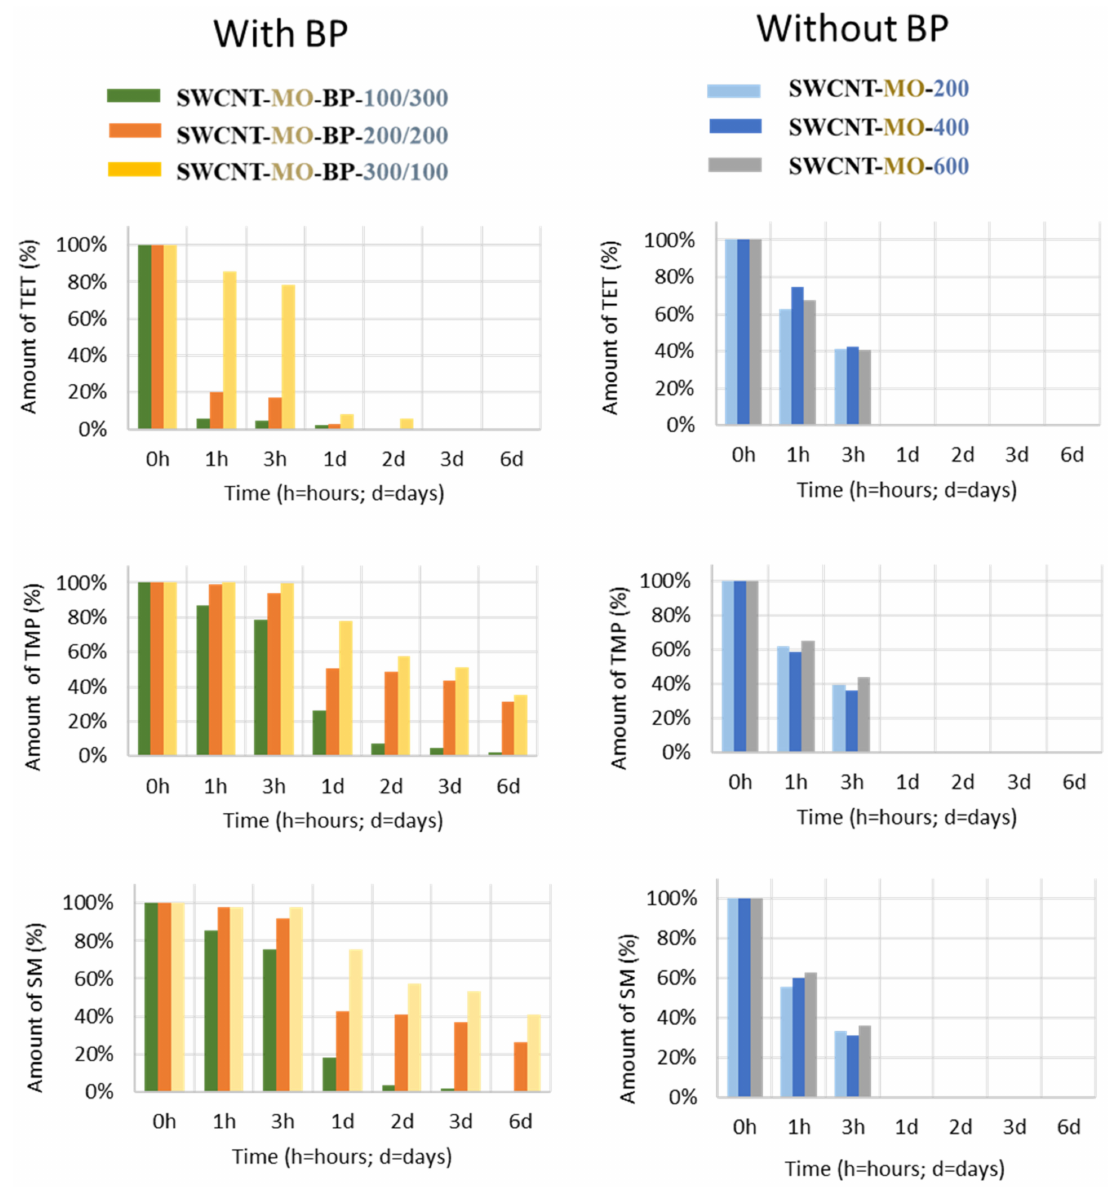
Figure 9. The evolution of ATB absorbed during the sorption experiments with SWCNT